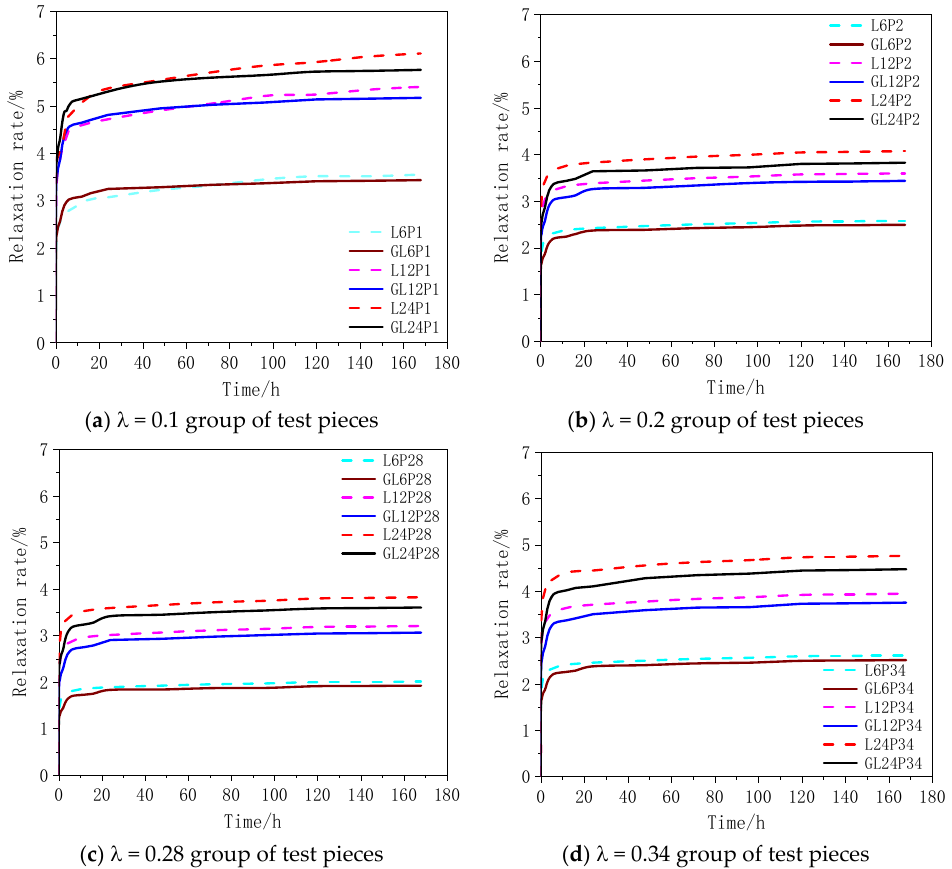
( c ) = 0.28 group of test pieces ( d ) = 0.34 group of test pieces Figure 8. ( a – d ) Relaxation rate-time relationship of CFRP